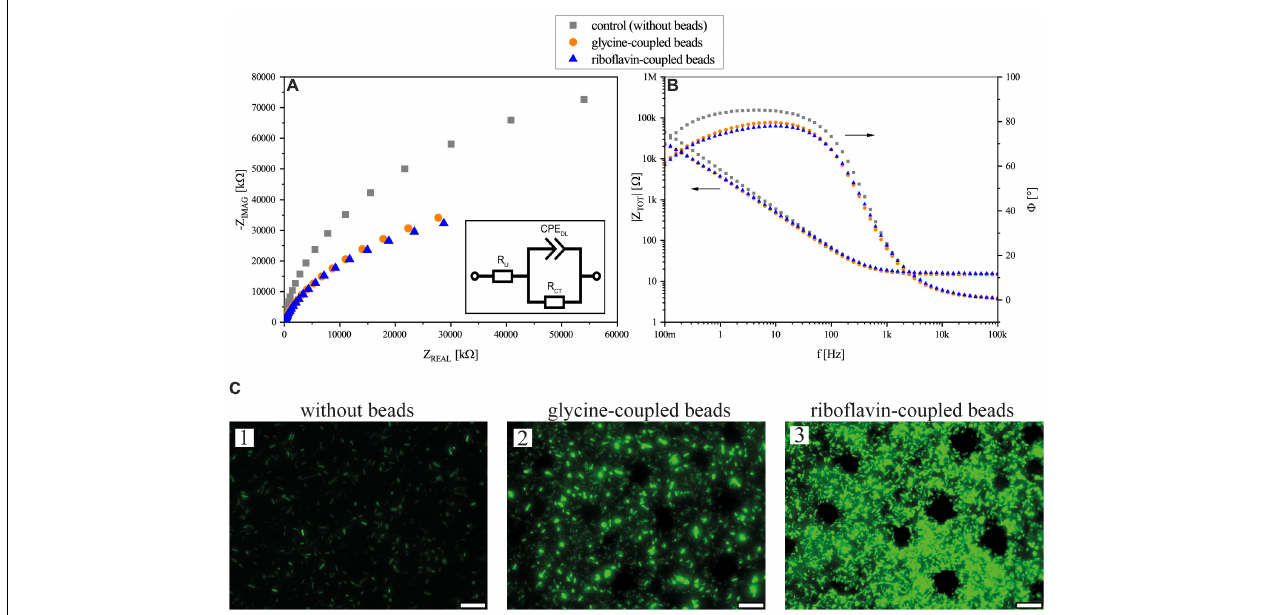
FIGURE 5 | Flow cell experiment results. (A) Nyquist presentation of EIS measurements after 24 h of flow cell operation. (B) Bode plot and phase angle of the EIS measurements of flow cells without beads, with glycine-coupled beads, and with riboflavin-coupled beads. In both plots (A,B) , flow cells without beads are depicted in gray squares, flow cells with glycine-coupled control beads in orange circles, and flow cells with riboflavin-coupled beads in blue triangles. Points represent average values of independent triplicates; arrows indicate the corresponding axis. The inset in (A) shows an equivalent electrical circuit for the BES flow cell; R CT : charge transfer resistance; R U : solution resistance; CPE DL : double layer constant phase element. (C) Fluorescence microscopy images of gfp -expressing MR-1 on ITO glass anodes in experiments without beads (1), with glycine-coupled control beads (2) and with riboflavin-coupled beads (3) after 24 h of incubation. Circular areas without cells are due to the position of magnetic beads. The scale bar indicates 25 µ